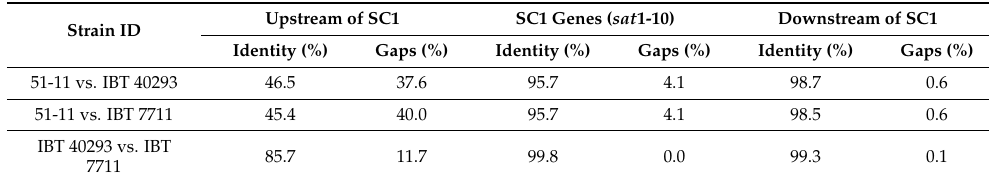
Table 4. Comparison of the genomic regions that comprise the SC1 of 51-11, IBT 40293, and IBT 7711 (scaffolds 31, 155, 234,